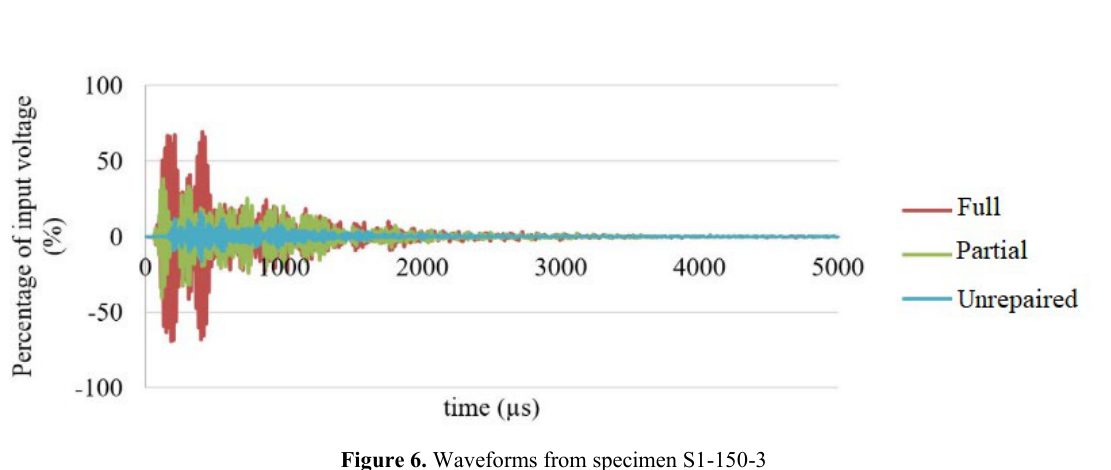
Figure 6. Waveforms from specimen